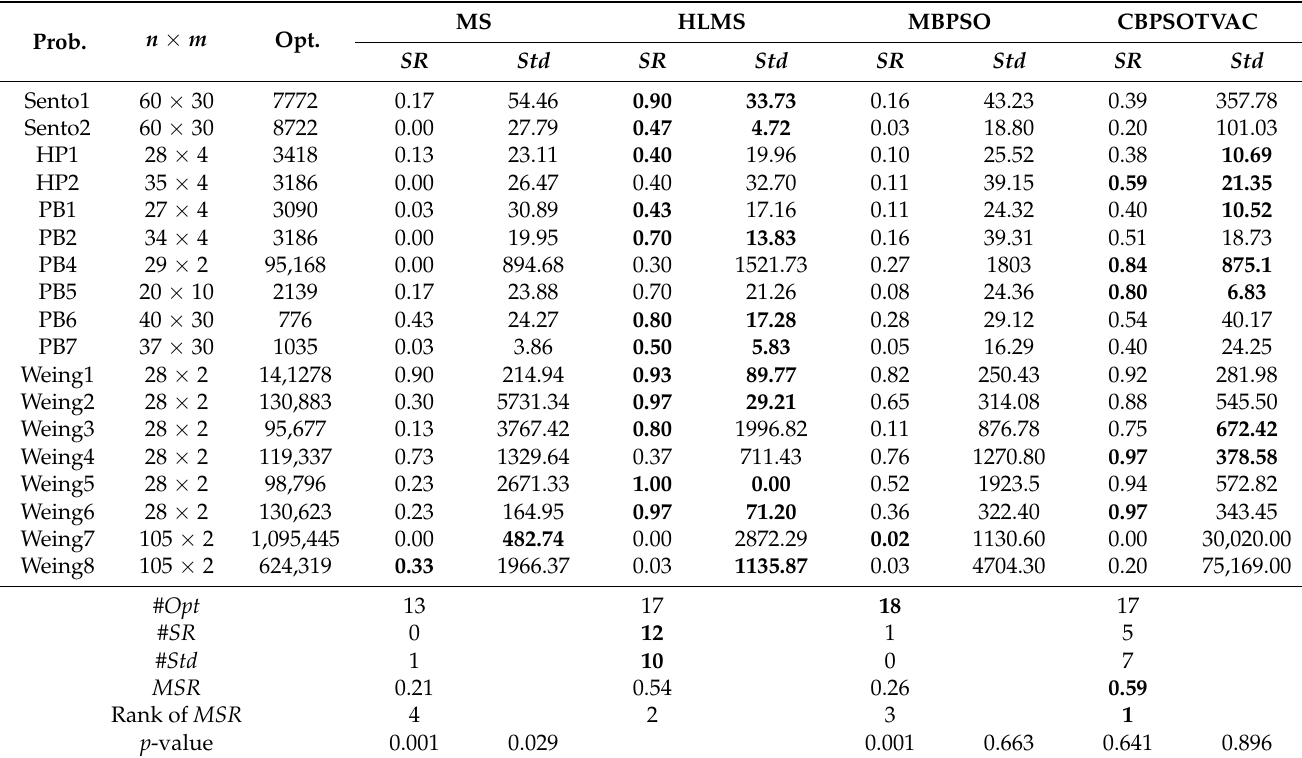
Table 2. The results of HLMS with 3 comparative algorithms for Test set I.